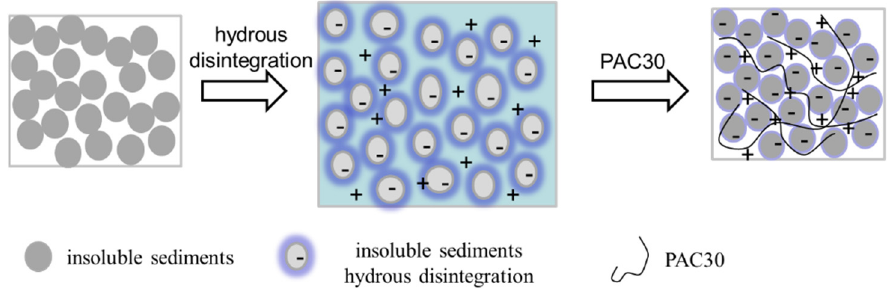
Figure 12. Schematic diagram of action mechanism of shrinkage agent.